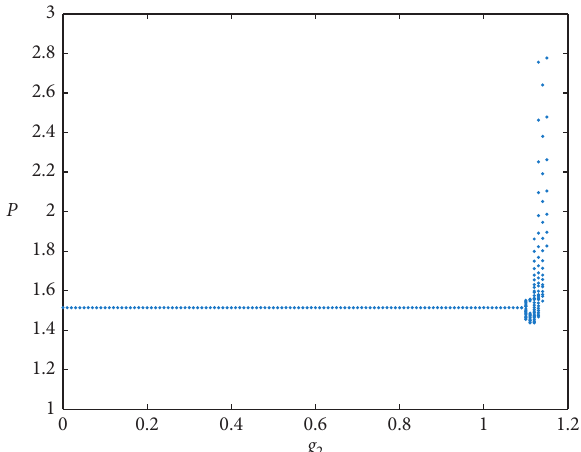
Figure 8: Influence of self-leadership adjustment coefficient on leadership effectiveness.